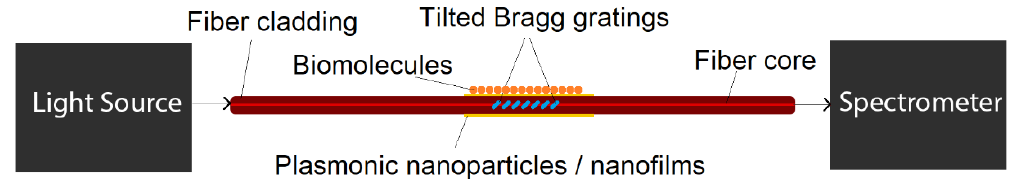
Figure 20. The schematic of a potential plasmonic biosensing setup based on tilted fiber Bragg